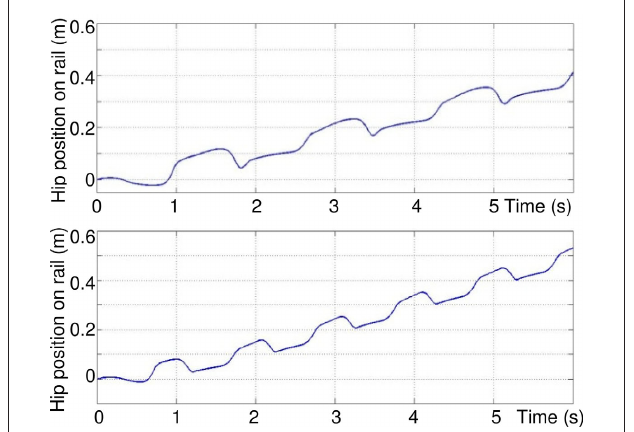
value on the rhythmic movement of the hip: s = s